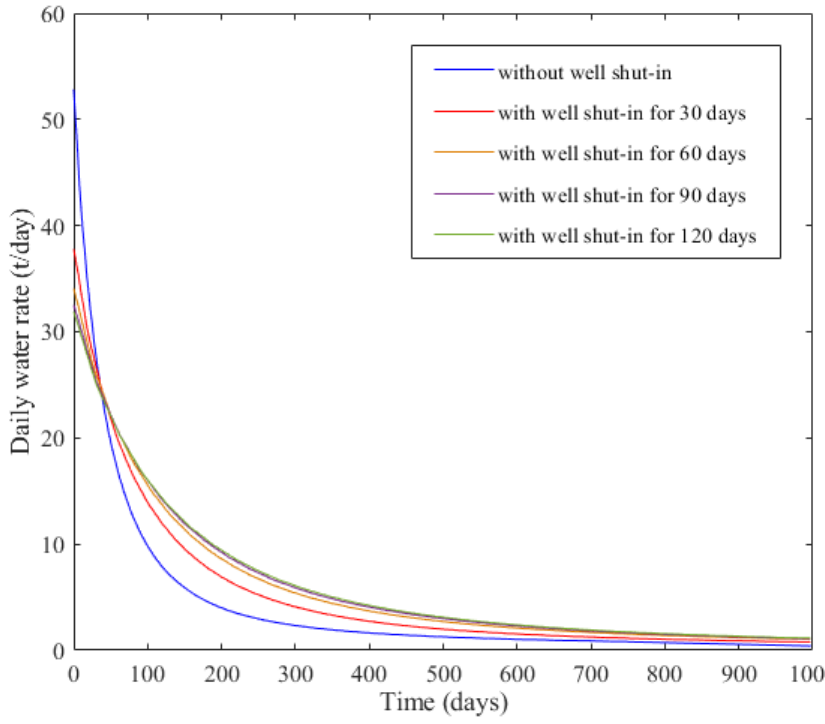
Figure 8. Water production rate for the first 1000 days after different shut ‐ in times.